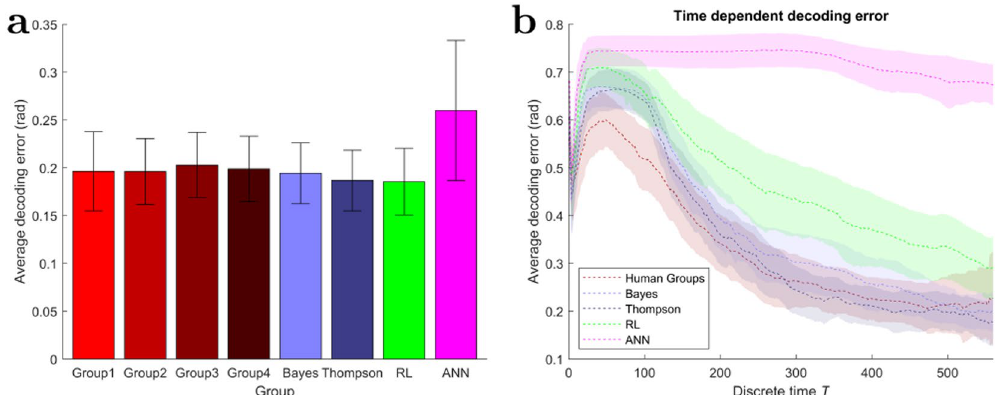
Figure 8. Decoding error. ( a ) The average decoding error produced by the different groups of players calculated with the spike triggered average of the whole batch. Error bars indicate 99% confidence intervals. ( b ) The temporal evolution of the decoding error displayed for the average human group and all four simulated groups. The shaded areas indicate 99% confidence